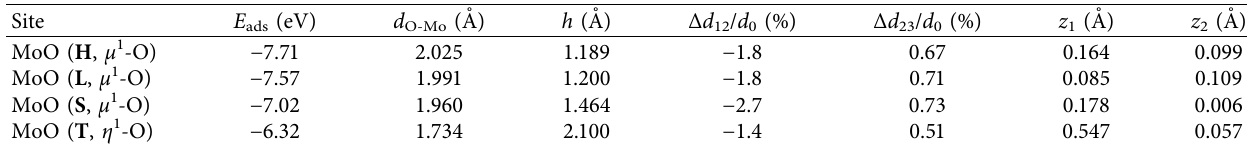
Table 3: Structural parameters O atom adsorption on the Mo (110)